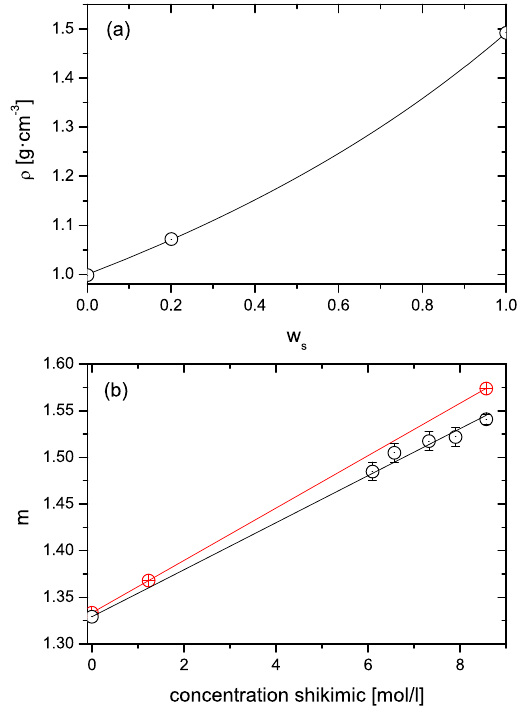
Figure 4. (a) Density vs. mass fraction parametrization of shikimic acid, the data point at w = 0 . 2001, ρ = 1 . 072gcm − 3 was measured with a pycnometer, the density of the solute ρ s = 1 . 492gcm − 3 was determined as described in the text, the line is a plot of Eq. (4). (b) Refractive indices vs. molarity. m TDL from high resolution Mie resonance spectra (black symbols), m D (red symbols), lines are lin- = ear fits for the two different wavelengths to Eq. (3): m TDL , H 2 O = 1 . 3334, m D,s = 1 . 574. 1 . 3292, m TDL,s = 1 . 541, m D , H 2 O